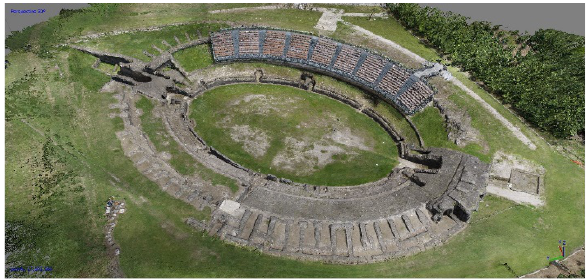
Figure 8: Prospective view of dense